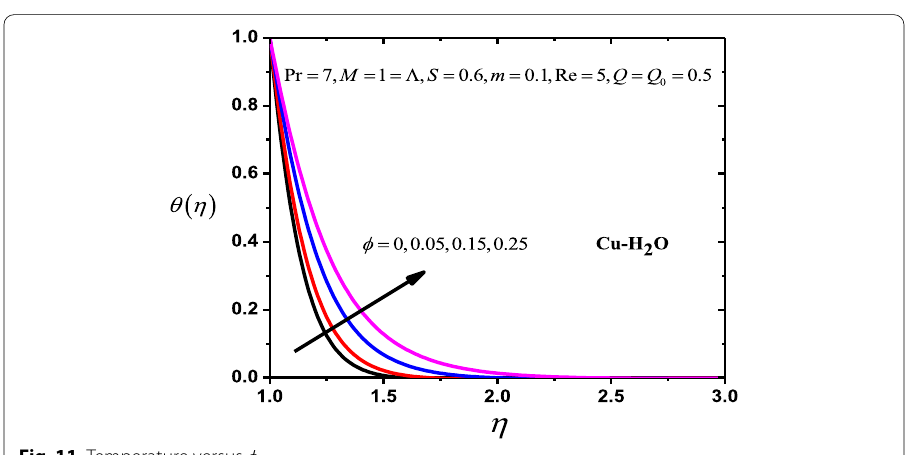
Fig. 11 Temperature versus